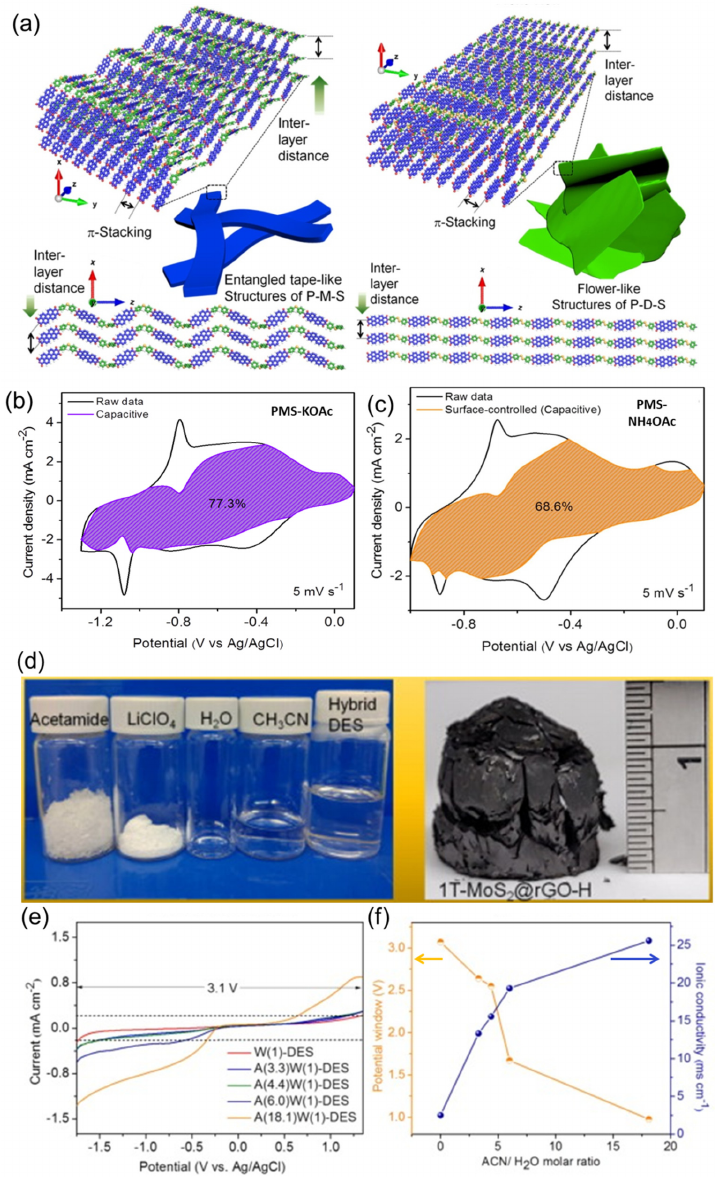
Figure 9. ( a ) Schematic representation showing the effect of mono- and di-sulfide linkers in the nanomorphology of perylenetetracarboxylic diimide-based redox-active polymers [141]. ( b , c ) CV with the capacitive (surface-controlled process) contribution of PMS polymer in the 27 m KOAc and 27 m NH 4 OAc WIS electrolytes, respectively. ( d ) Photographs of water/acetonitrile-mixed DES electrolyte and the MoS 2 composite material with the reduced graphene oxide after the freeze-drying process [142]. ( e ) LSV and ( f ) ESW (orange line) vs. ionic conductivity (blue line) plots of the water/acetonitrile-mixed DES electrolyte under various conditions.